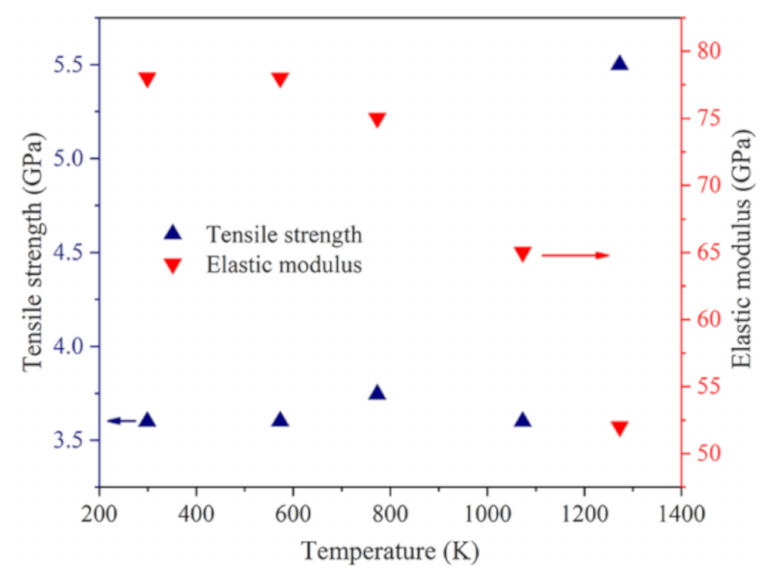
Figure 11. Elastic modulus [26,30] and the predicted elastic strength of the silica fibers and the bonding between the fibers at various